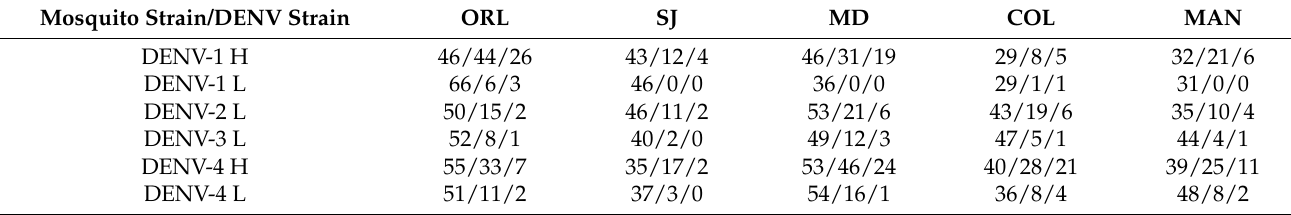
Table A3. Sample sizes per experimental group of Aedes aegypti exposed to dengue viruses.